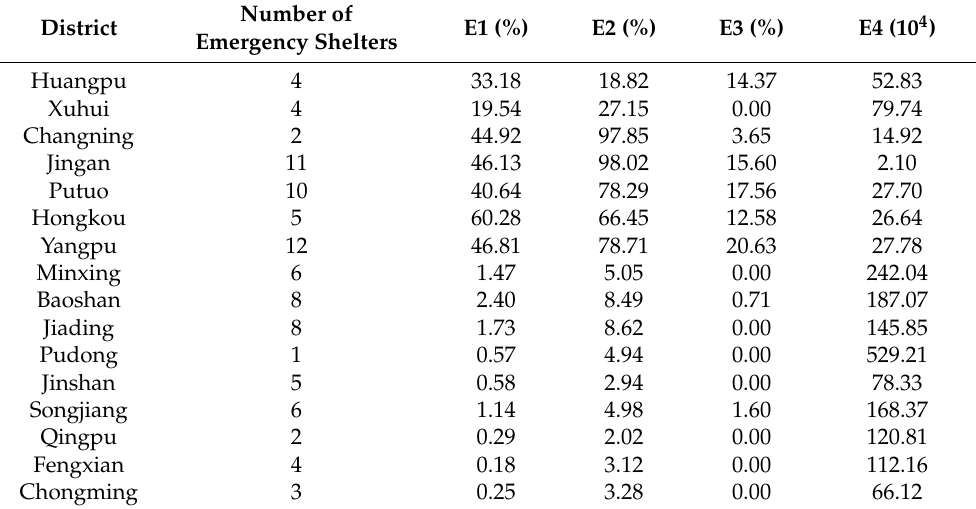
Table 5. Fairness indicators of emergency shelters in each district of